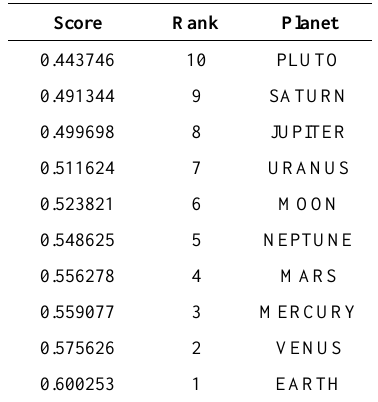
Table 7. TOPSIS results with equal weights